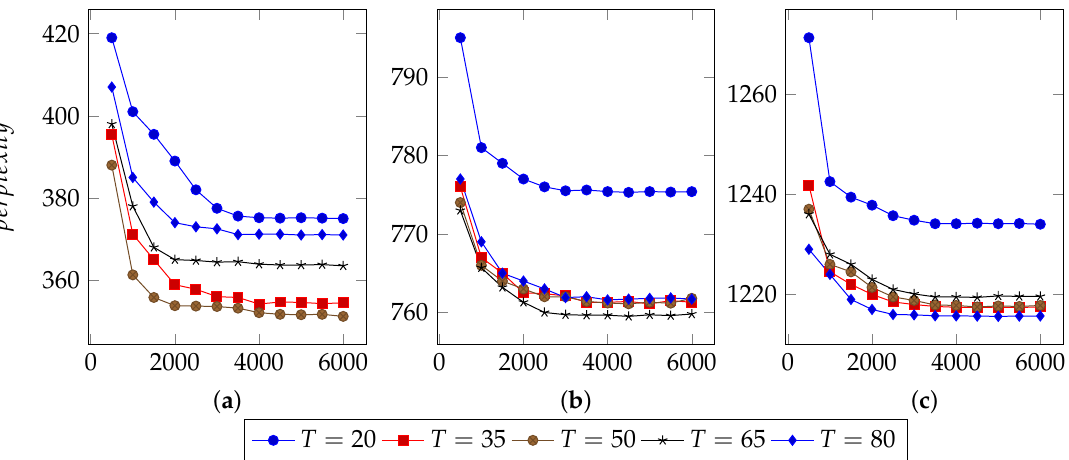
Figure 3. Selection of I for FTP. ( a ) Perplexity for model with 40% n-grams used; ( b ) Perplexity for model with 60% n-grams used; ( c ) Perplexity for model with 80% n-grams used.